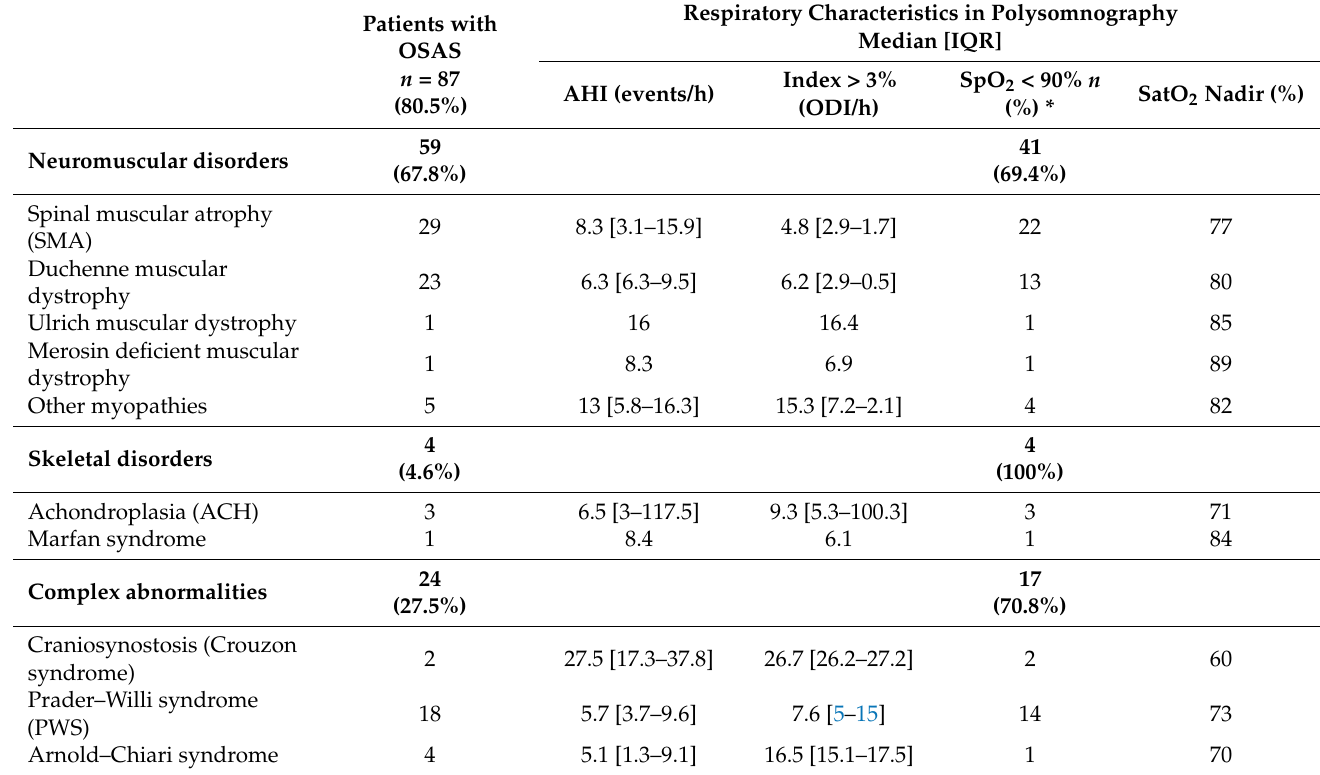
Table 3. Respiratory parameters recorded using